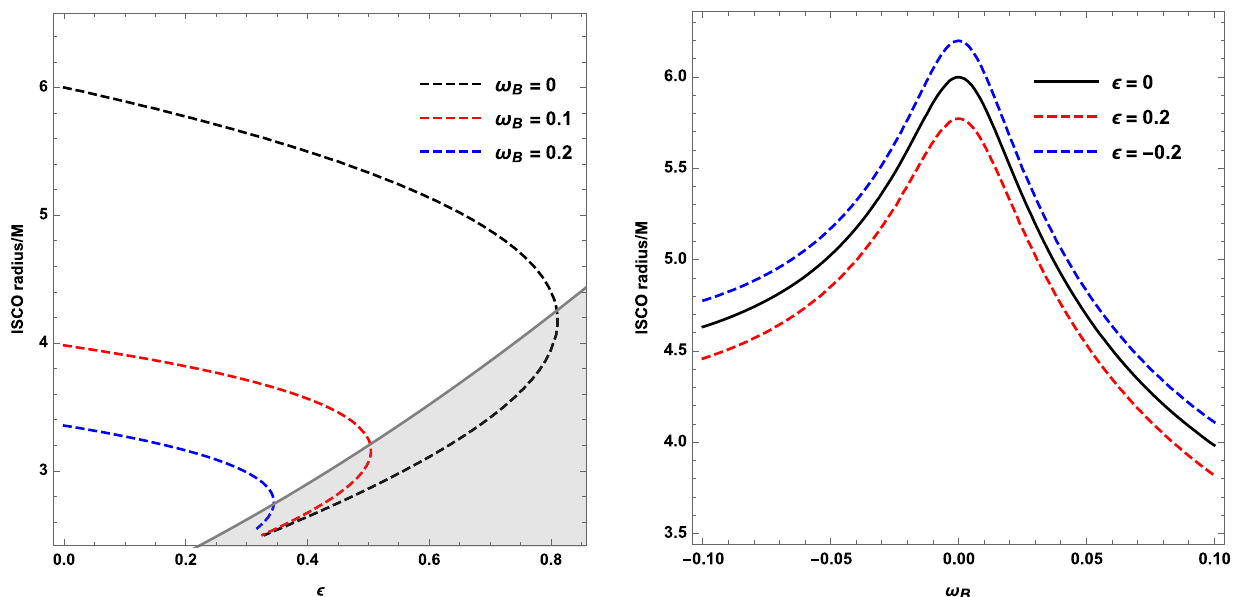
Fig. 3 ISCO radius of a test particle orbiting in the equatorial plane of a quasi-Schwarzschild compact object for different values of the magnetic interaction (left panel) and deformation parameter (right panel)